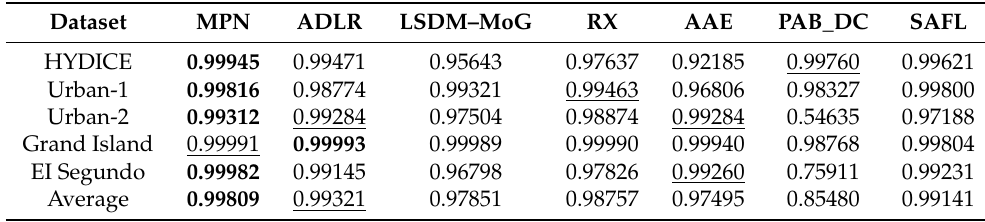
(cid:16) (cid:17) P d , P f obtained by MPN and six compared methods.